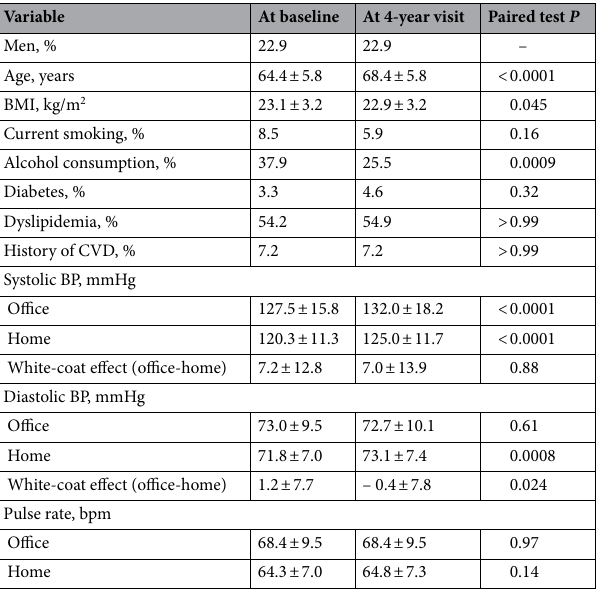
Table 1. Participants’ characteristics at baseline and 4-year visit. BMI body mass index, CVD cardiovascular disease, BP blood pressure.